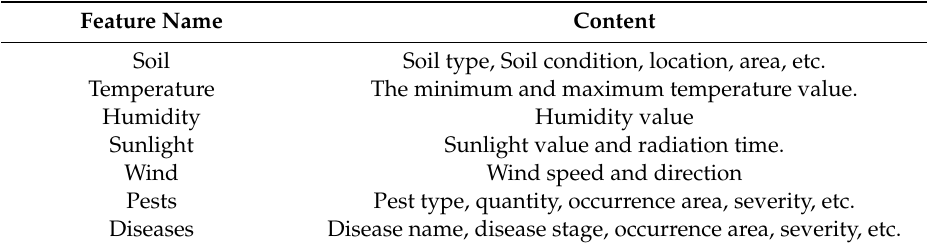
Table 1. Key features of environmental data in agricultural cases.